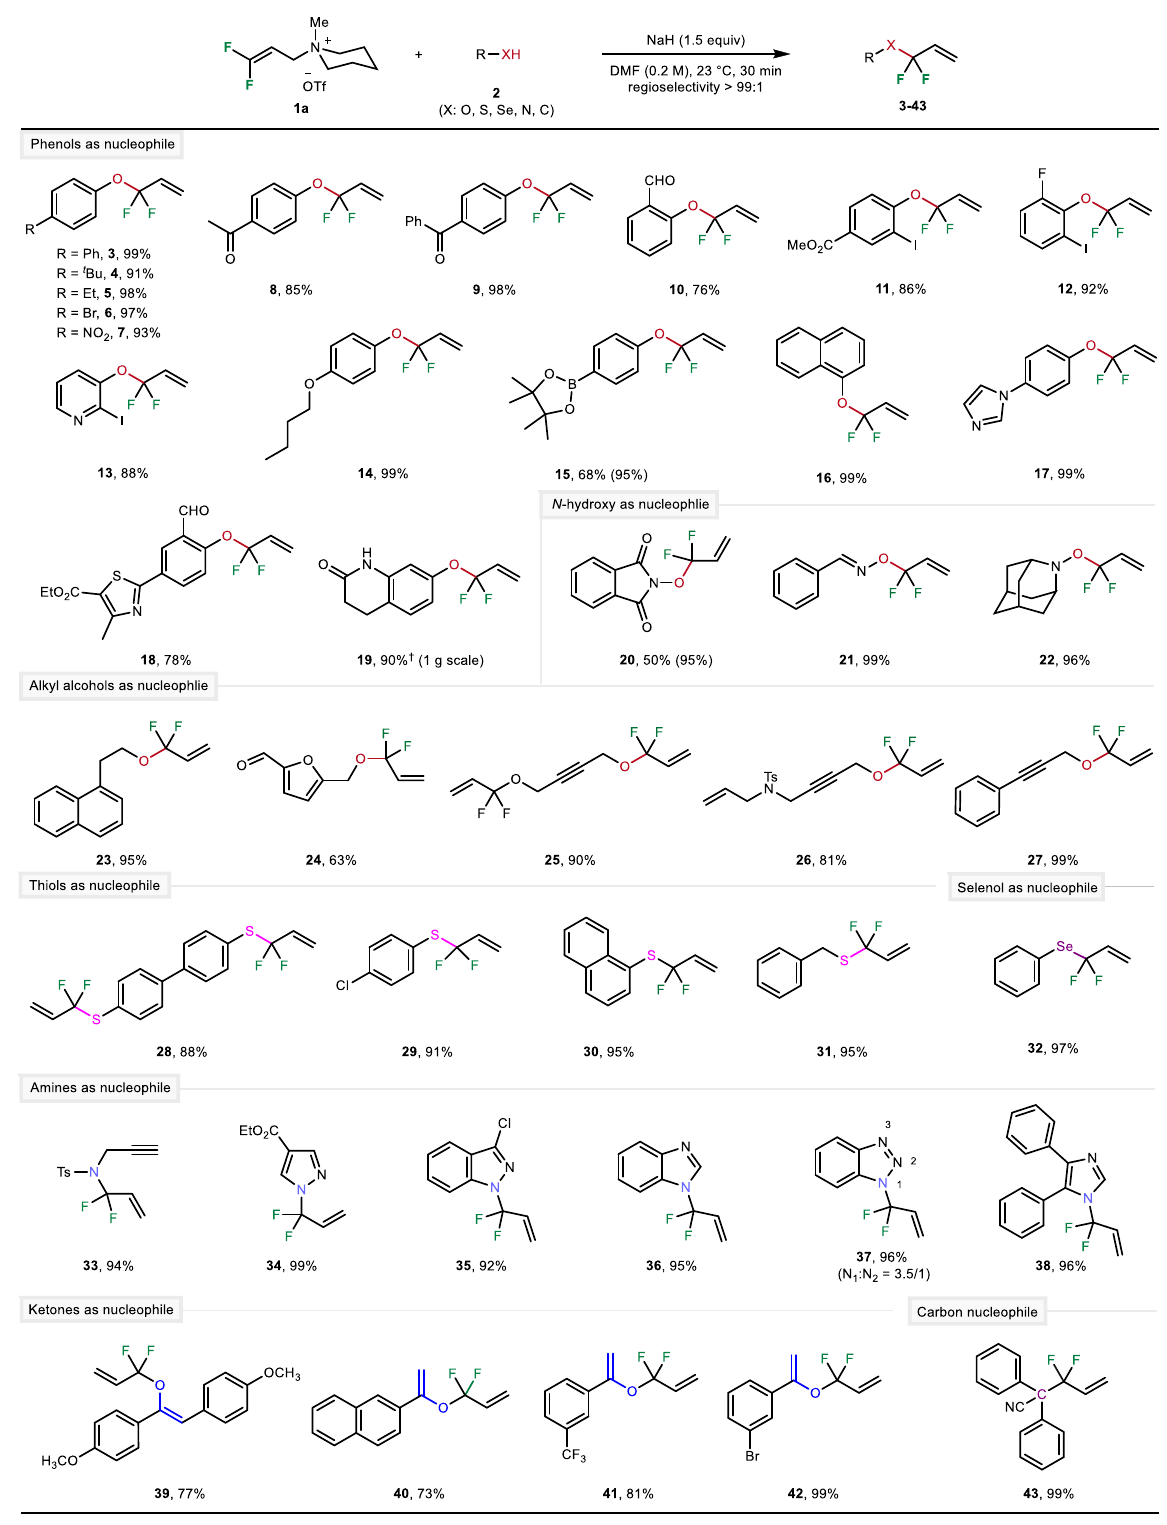
Fig. 3 Regioselective substitution of 1a by different O-, N-, S-, Se- and C-nucleophiles: Substrate scope. Standard reaction conditions: 1 (1.2 equiv), 2 (1 equiv), NaH (1.5 equiv) in DMF (0.2 M), the reaction mixture was performed at 23 °C under argon atmosphere for 30 min, isolated yield, the α / γ regioselectivity was determined by crude 19 F NMR analyses. † Cs 2 CO 3 (0.5 equiv) and toluene (0.1 M) were used as base and solvent, the reaction was performed at 50 °C under air atmosphere for 18